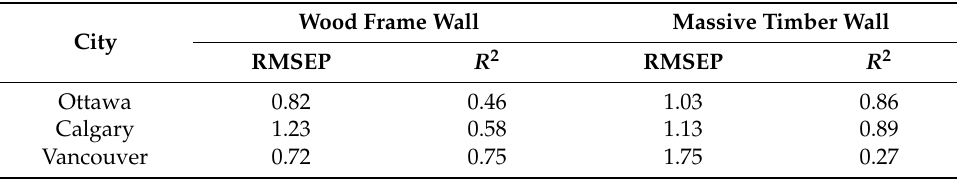
Table 3. Summary statistics for forecasting relative humidity for the three